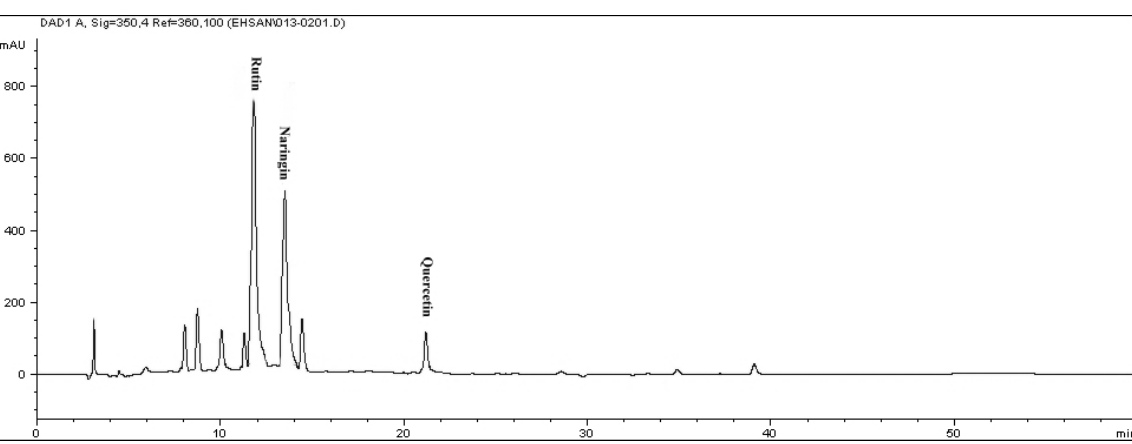
Figure 1. The RP - HPLC chromatogram of flavonoid compounds in methanolic extract of Citrus aurantium bloom. Identified compounds: Rutin, naringin and quercetin .